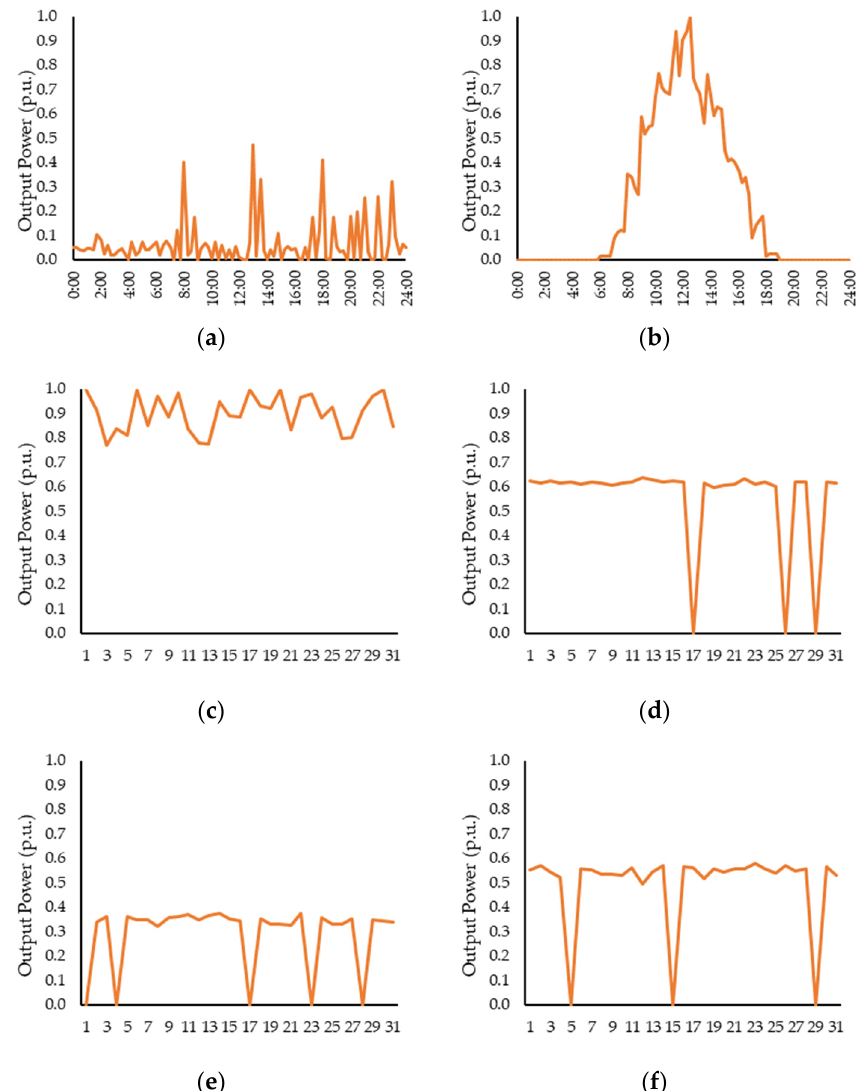
Figure A1. Power output simulations from: ( a ) wind generation model; ( b ) solar PV generation model; ( c ) small hydro generation model; ( d ) biomass generation model; ( e ) biogas generation model; and ( f ) waste generation model.